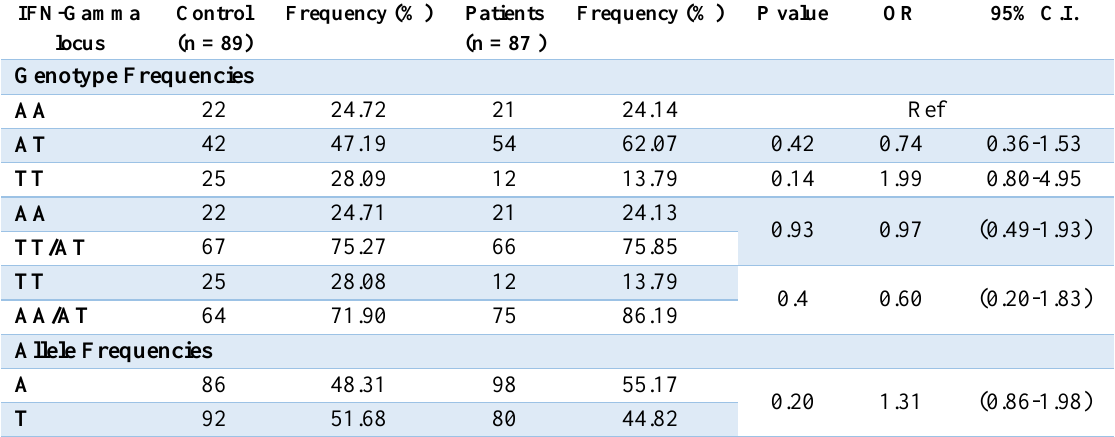
Table 3. Adjusted * values for genotypes and allele frequencies of Interferon-gamma (+874) T/A single nucleotide polymorphism among control and patients groups.